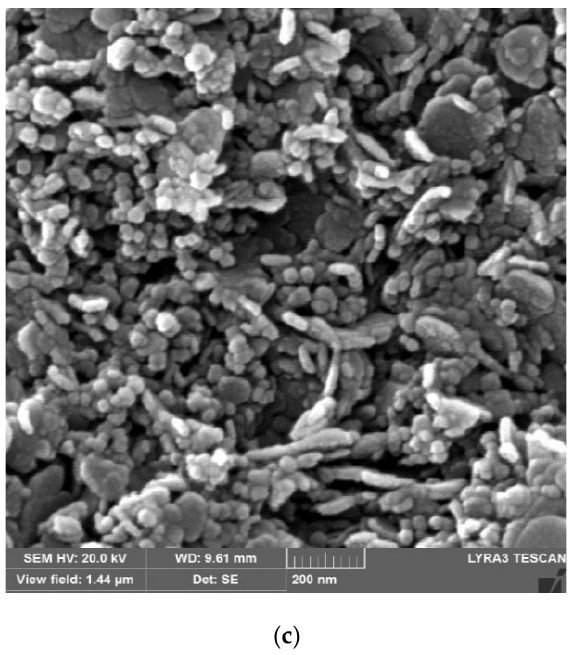
Figure 4. Results from FESEM analysis for LDH-TiO 2 matrix synthesized at 250 °C at ( a ) 0.5:1, ( b ) 1:1, and ( c ) 1.5:1 ratios.